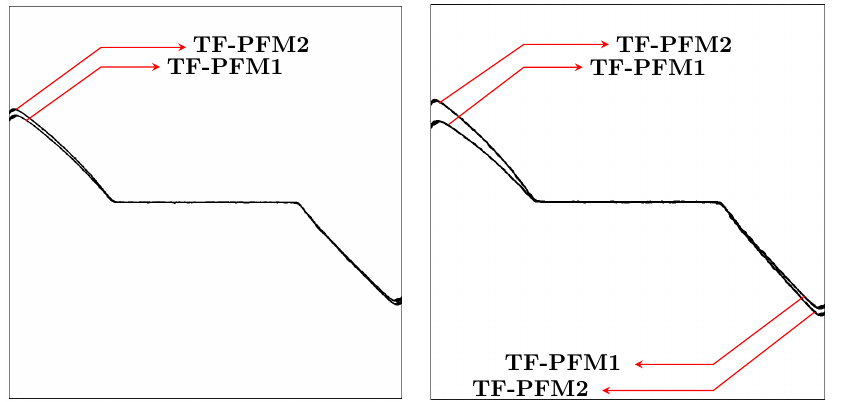
Figure 19. Comparison of the crack paths using TF-PFM1 and TF-PFM2 when Θ = 5 ( left ) and Θ = 6 ( right ) at the final computational time.